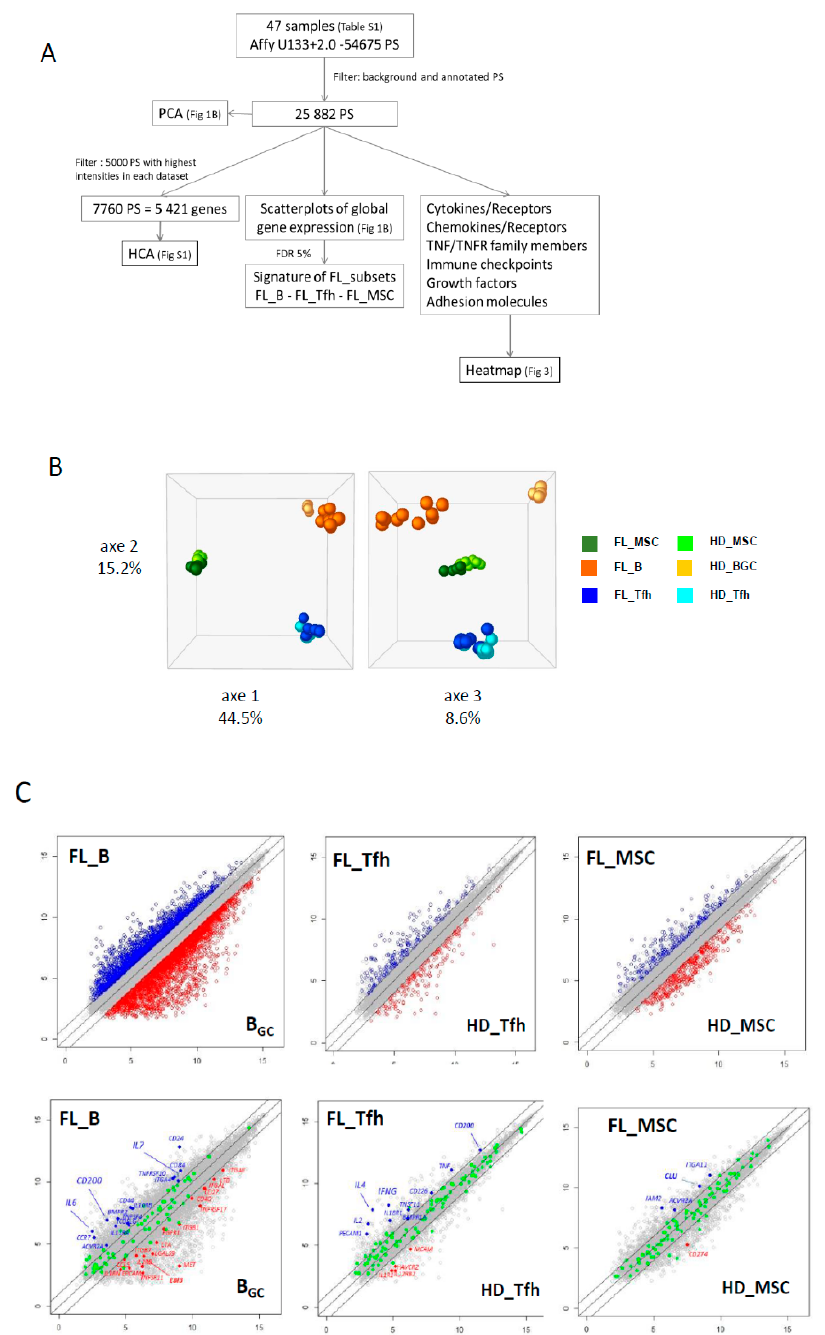
Figure 1. ( A ) Microarray data analysis strategy. ( B ) Principal component analysis (PCA) shows tight clustering of the mesenchymal stromal cell (MSC) compartment, B (B) and T follicular helper (Tfh) lymphocytes from normal and tumoral contexts. The first three axes total 68.3% of the total inertia of the dataset. ( C ) Scatterplots of pairwise global gene expression comparison between FL (follicular lymphoma) and non-tumoral samples, in B lymphocytes (left panel), Tfh (middle panel) or stromal cells (right panel). Gene expression values are plotted on a log scale. Genes that were differentially expressed (FDR (false discovery rate) ≤ 5%) with a fold change ≥ 2 (logFC ≥ 1) are indicated in red and blue. Top panel: representation of all annotated genes (21,319 PS (probesets) in B lymphocytes, 19,859 PS in Tfh and 20,142 PS in stromal cells). Bottom panel: highlight of genes (in green) differentially expressed (FDR ≤ 5%) with a fold change ≥ 2 (logFC ≥ 1).